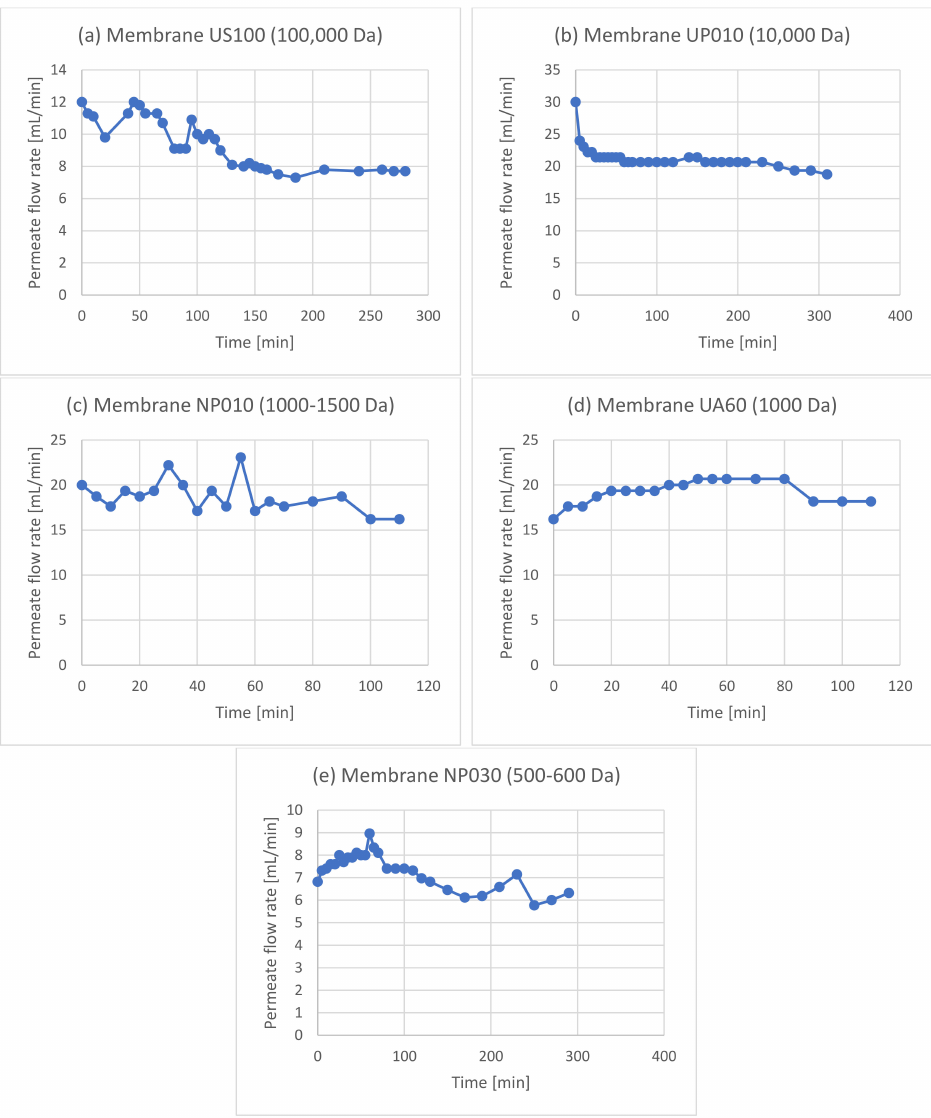
Figure A1. Permeate flow rates observed in the membrane treatment scheme after solid–liquid extraction in which two ultrafiltration steps (( a ) US100, ( b ) UP010) were used in line and the permeate from the 10,000 Da membrane was split into three equal parts and was treated with three different nanofiltration membranes (( c ) NP010, ( d ) UA60, ( e )